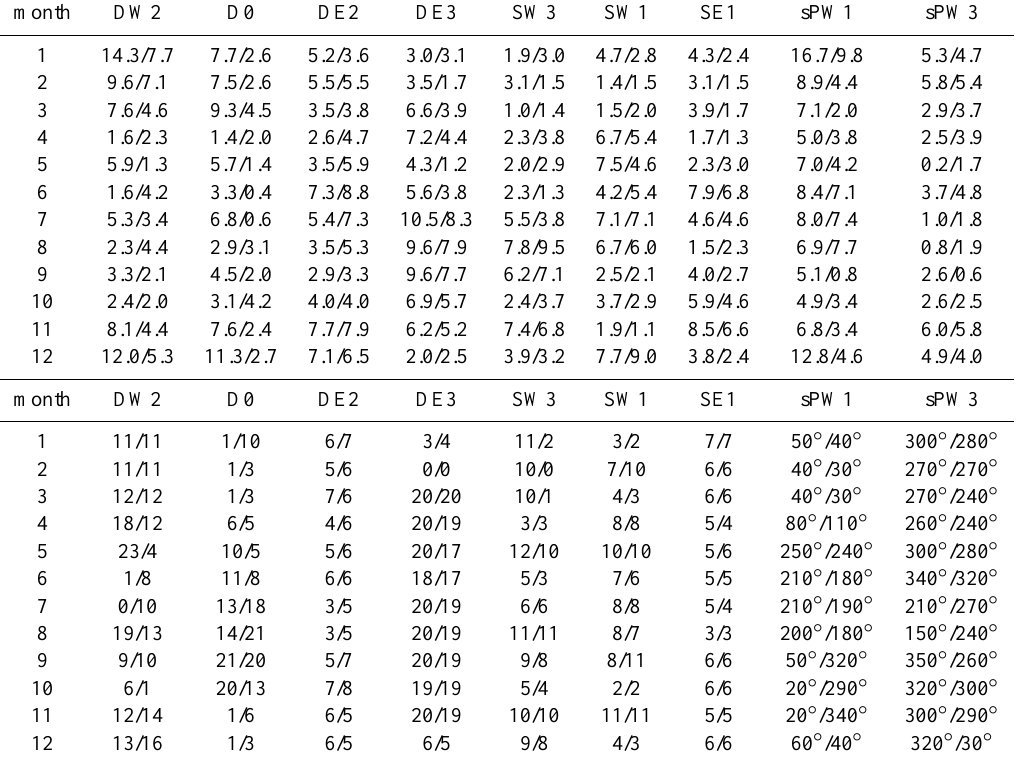
Table 2. Zonal wind tidal amplitudes [m/s] (top) and phases [UT] (bottom) observed with CHAMP at 400 km altitude along the geomag- netic/geographic equator. The last two columns contain the amplitudes [m/s] (top) and longitudes of maximum (bottom) for the stationary planetary waves sPW1 and sPW3. The damping of the amplitude due to the binning procedure as discussed in Sect. 5 is